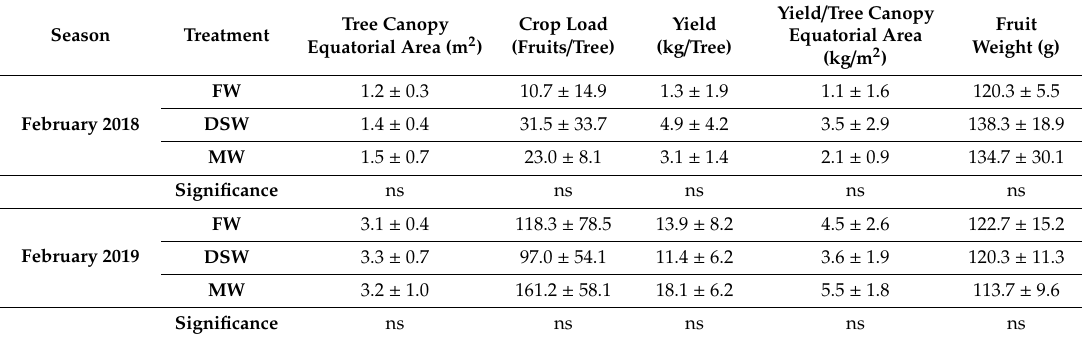
Table 3. Tree canopy equatorial area, crop load, yield, yield / tree canopy equatorial, and fruit weight for the two experimental seasons and for the three irrigation treatments (fresh water, FW; desalinated seawater, DSW; and mixed water, MW). Each value is the average ± standard deviation of the measurements performed in two inner trees per treatment (six central trees in each replicate per treatment). ns means non-significant di ff erences between treatments according to Tukey’s HSD test (P ≤ 0.05).